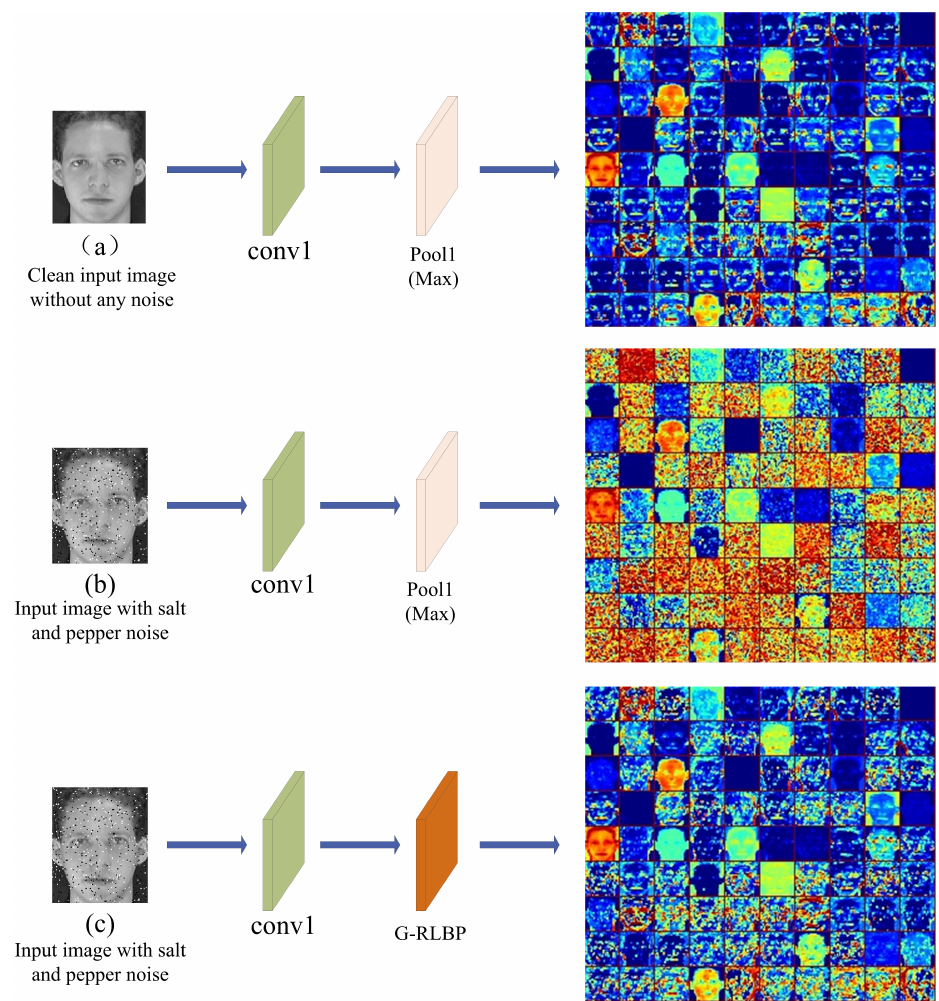
Figure 10. The feature maps of different pooling layers in the Alexnet. Conv1 indicates the first convolutional layer in the networks. ( a ) The output of Pool1 layer without injecting any noise into the input image in the baseline Alexnet; ( b ) the output of Pool1 layer in the baseline Alexnet when the input image is injected with salt and pepper noise ( d = 0.05); and ( c ) the output of the G-RLBP pooling layer when the input image is injected with the same noise as ( b